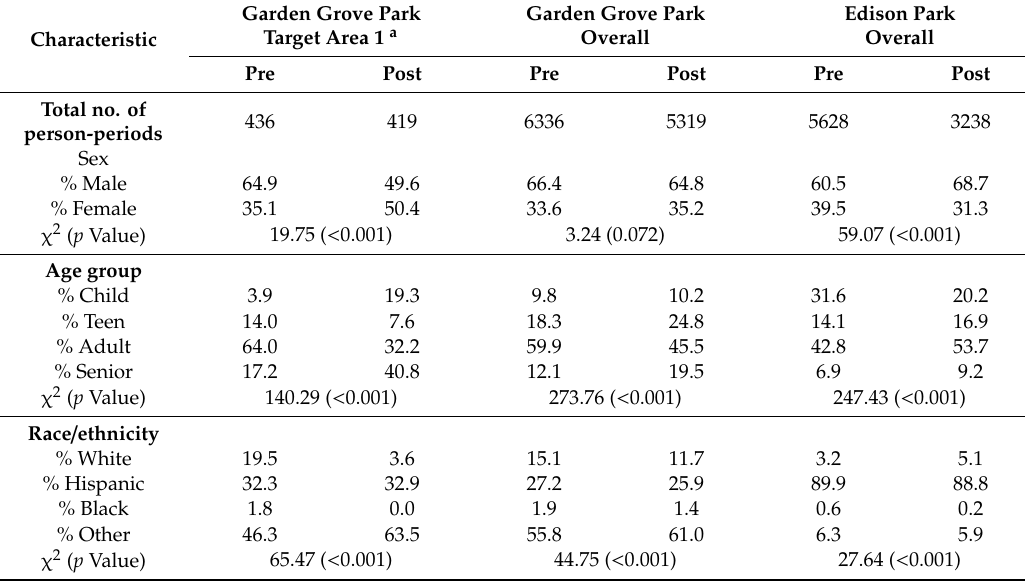
Table 1. Demographic characteristics of Park Users, pre- and post-intervention.